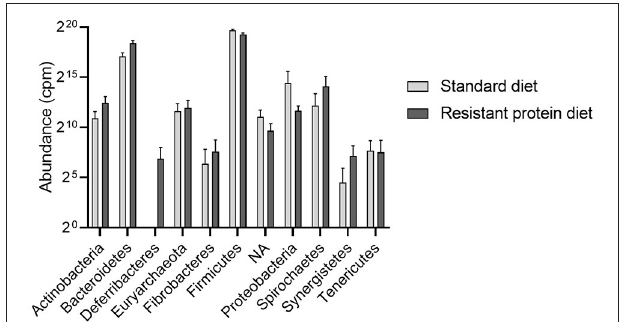
FIGURE 6 | The effects of standard and resistant protein diet on the distribution of phylum abundance in pig faecal microbiota at day 20 showing the relative abundance of the dominant phyla. Data represent the mean and SD ( n = 3 per group). There were no significant differences between groups for any phyla. NA, phylum unspecified; cpm, counts per million.